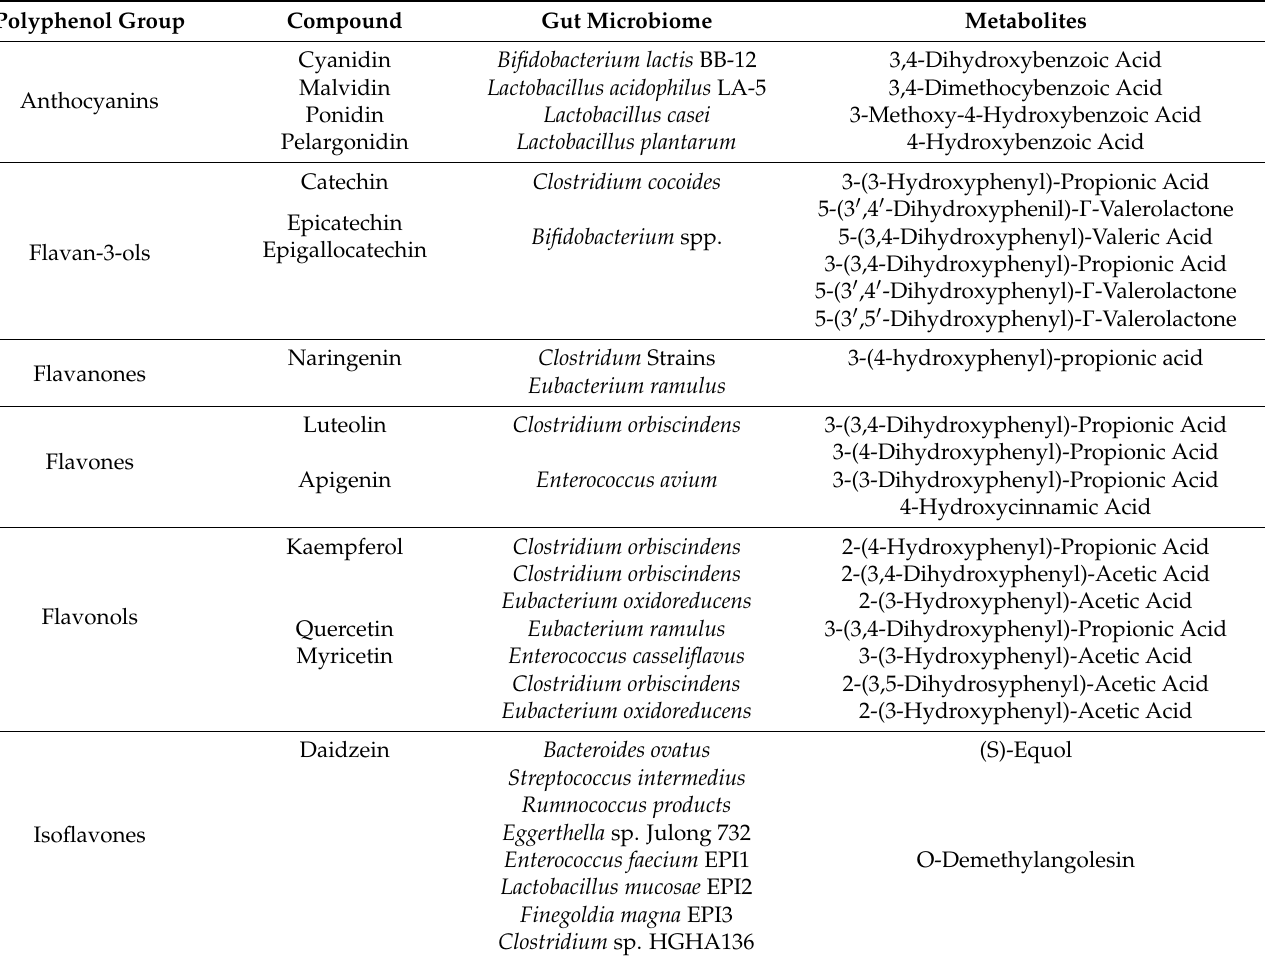
Table 1. Biotransformation of polyphenols by gut microbiota and main metabolites (Adapted from Marin et al.